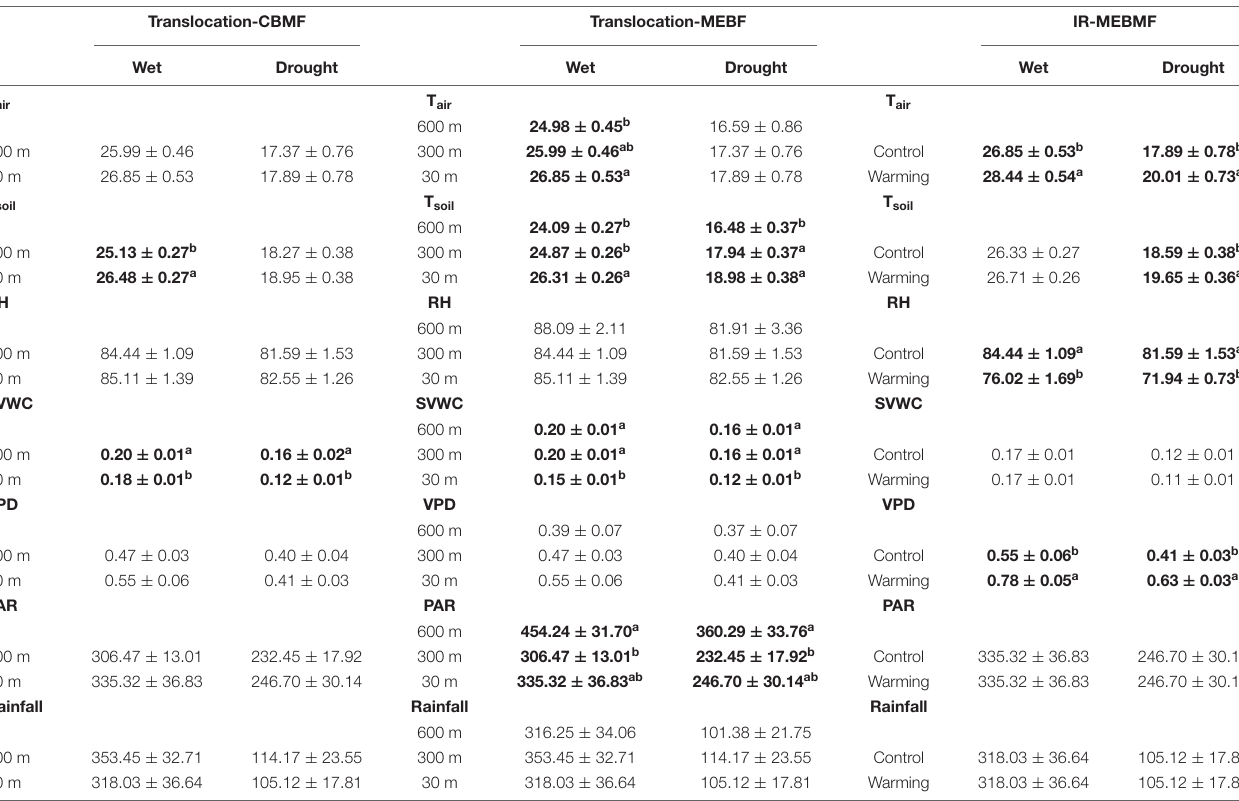
TABLE 1 | The average monthly air temperature (T air , ◦ C, n = 24), soil temperature (T soil , ◦ C, n = 72), air relative humidity (RH,%, n = 24), soil volumetric water content (SVWC, m 3 m − 3 , n = 72), vapor pressure deficit (VPD, kPa, n = 24), photosynthetically active radiation (PAR, µ mol m − 2 s − 1 , n = 24) and rainfall (mm, n = 24) in the wet and dry seasons from 2016 to 2020 for coniferous and broadleaf forest (CBMF), mountain evergreen broadleaf forest (MEBF) and monsoon evergreen broadleaf forest